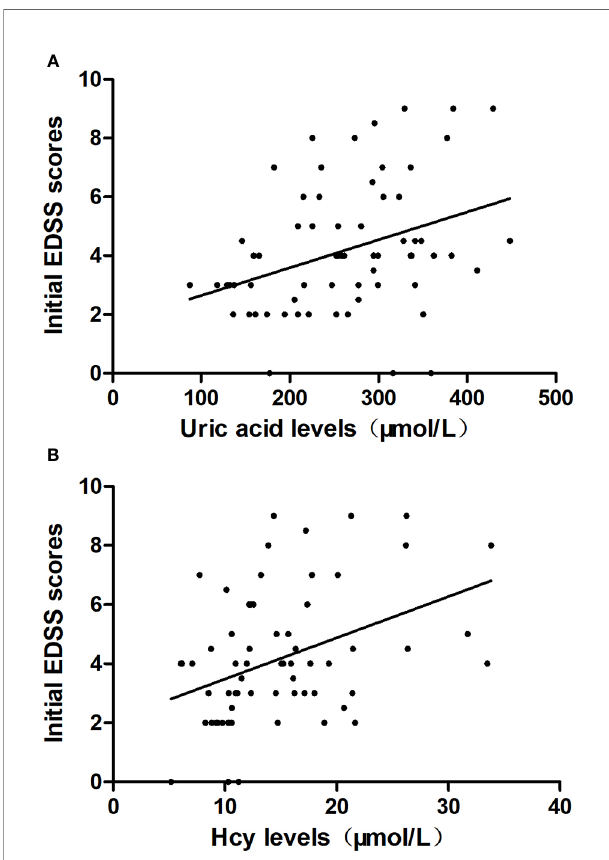
FIGURE 2 | The correlation between uric acid levels, homocysteine (Hcy) levels and the initial Expanded Disability Status Scale (EDSS) scores. (A) The correlation between uric acid levels and the initial EDSS scores is shown. (B) The correlation between Hcy levels and the initial EDSS scores is shown.